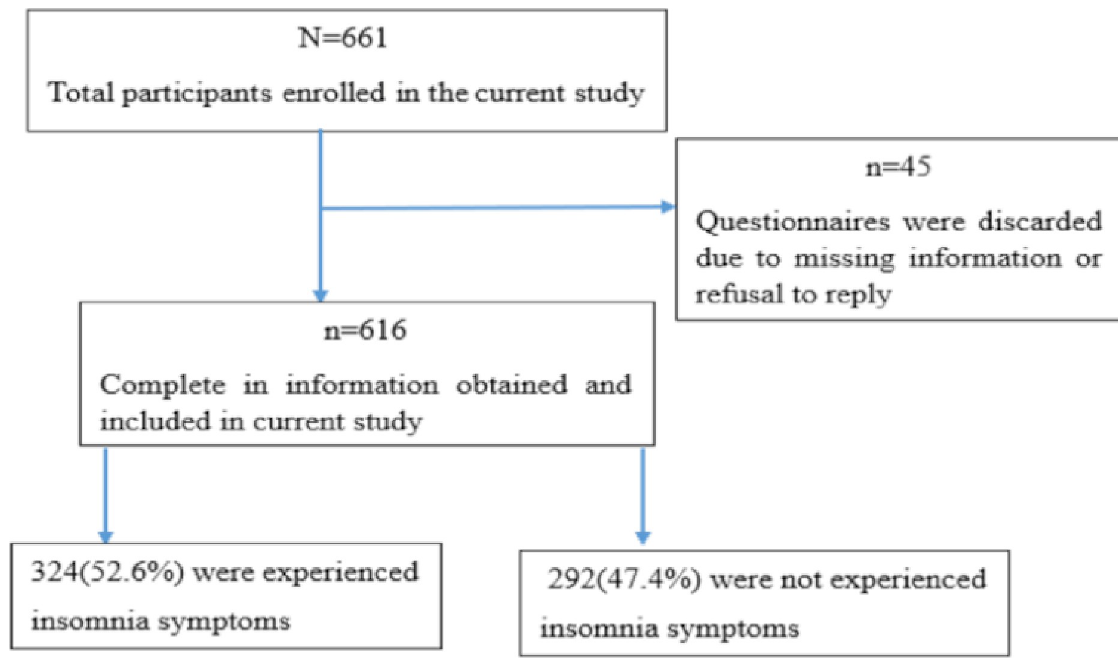
Fig 1. Illustrative summary of major